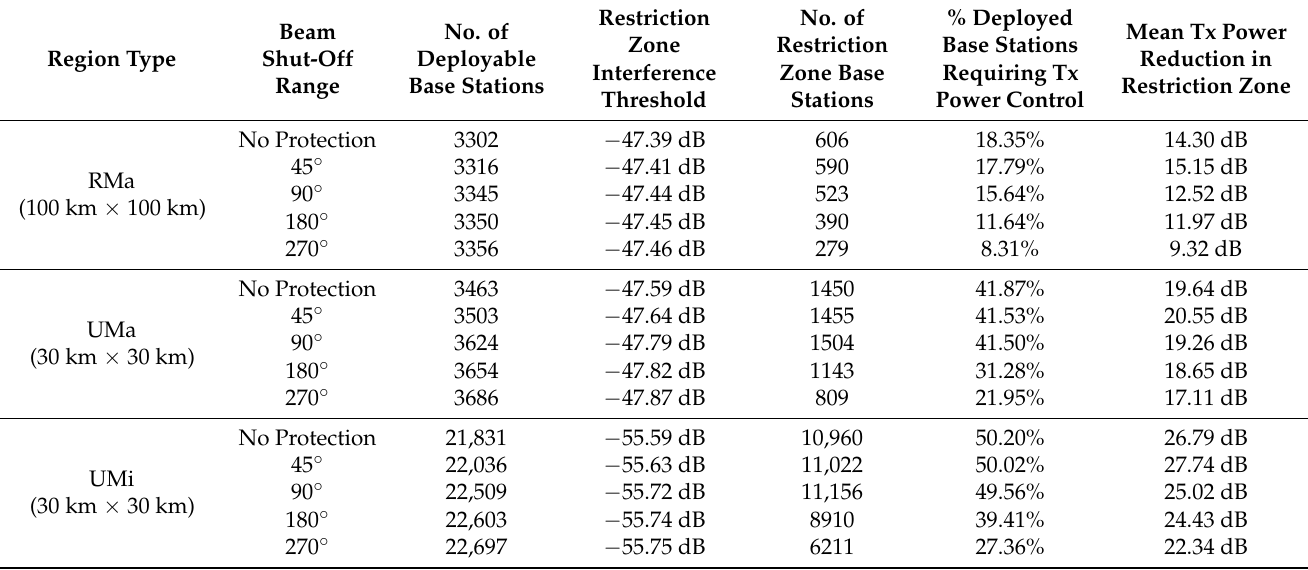
Table 3. Mean transmission (Tx) power reduction in the restriction zone for RMa, UMa, and UMi, using a 4 × 4 antenna array.